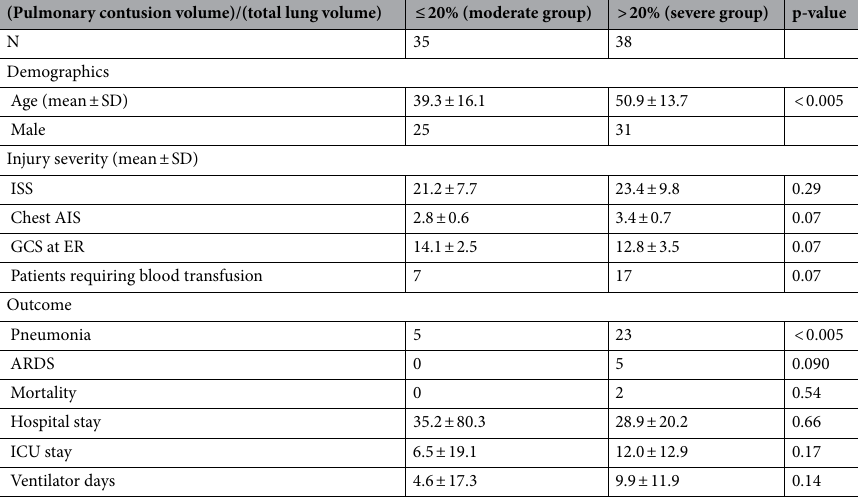
Table 2. Comparison between moderate and severe groups. ARDS acute respiratory disease syndrome, AIS abbreviated injury scale, ER emergency room, GCS Glasgow coma scale, ICU intensive care unit, ISS injury severity score, SD standard